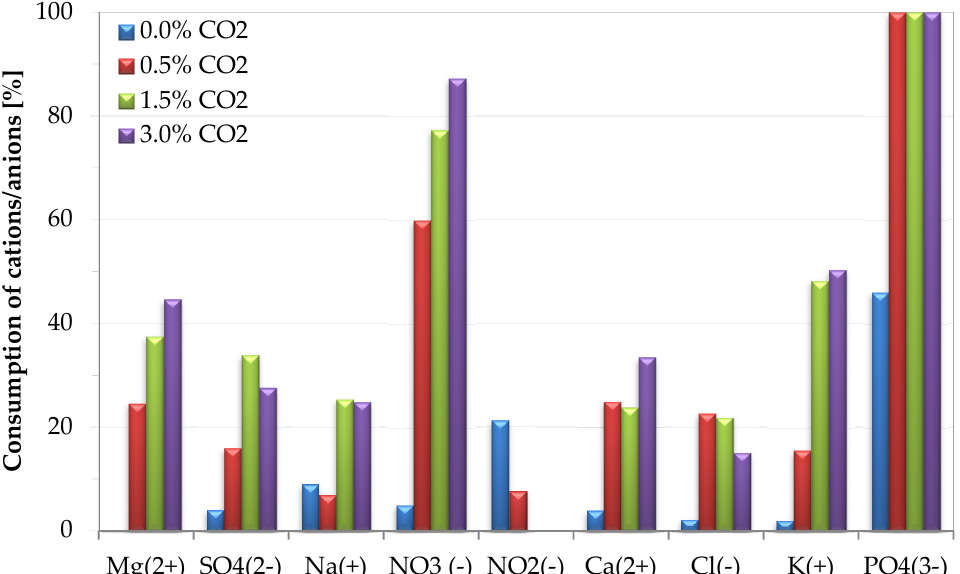
Figure 4. E ff ect of CO 2 content on nutrient consumption e ffi ciency during cultivation of S. almeriensis . Figure 4. Effect of CO 2 content on nutrient consumption efficiency during cultivation of S. almeriensis . Standard deviation was less than 5% in all operative Standard deviation was less than 5% in all operative conditions.